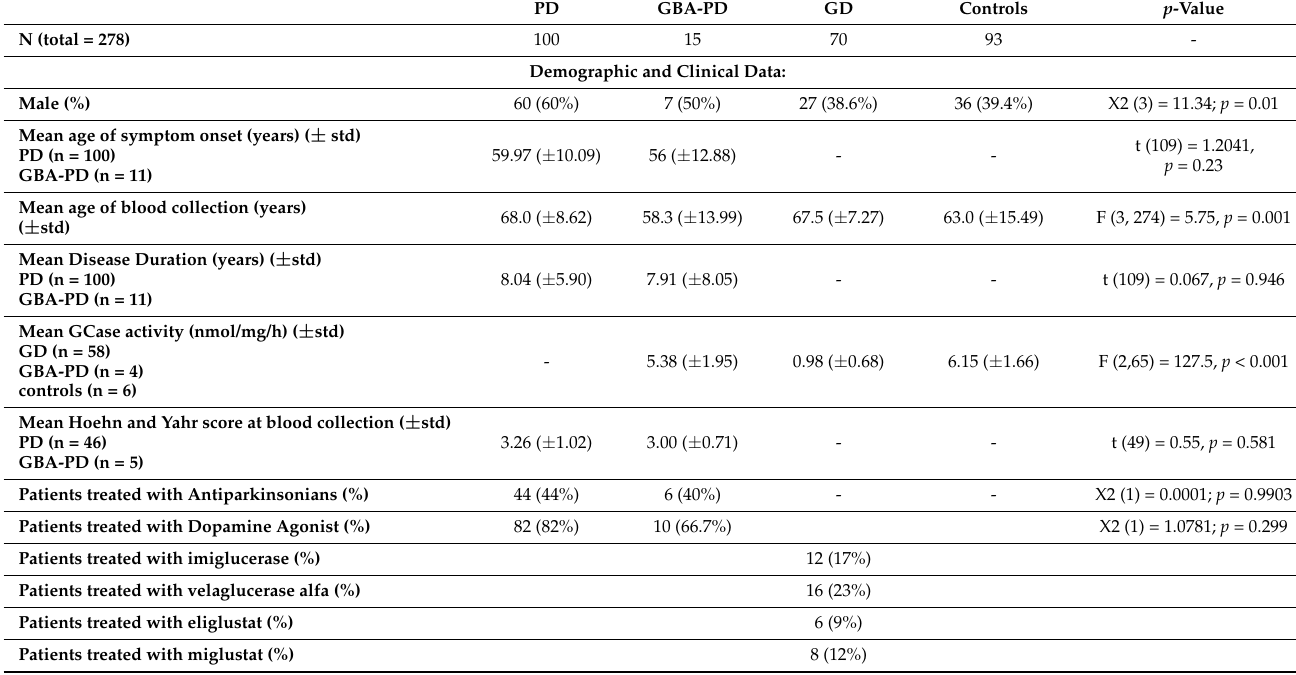
Table 1. Clinical, demographic and therapy data of the patient and control